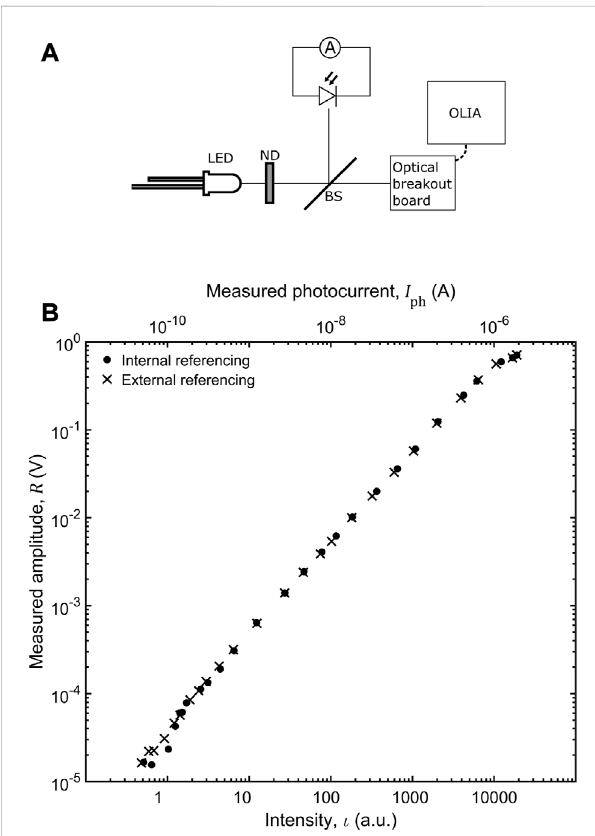
FIGURE 9 (A) Optical setup used to test the performance of OLIA and its optical breakout board. Modulated light from an LED is attenuated using a series of neutral density fi lters (ND) before striking a glass microscope slide that serves as a beam-splitter. The transmitted light strikes the ampli fi ed silicon photodiode on the optical breakout board, and the output signal from the breakout board is connected to the input terminals of OLIA. The re fl ected light strikes a separate photodiode, and the resulting photocurrent is measured using an electrometer. The photocurrent measured by the electrometer is proportionaltotheintensityoflightincidentonOLIA ’ sphotodiode. (B) Plot of amplitude R recorded by OLIA vs. intensity of light incident on OLIA ’ s sensor (in arbitrary units). The upper x -axis shows the photocurrent measured by the